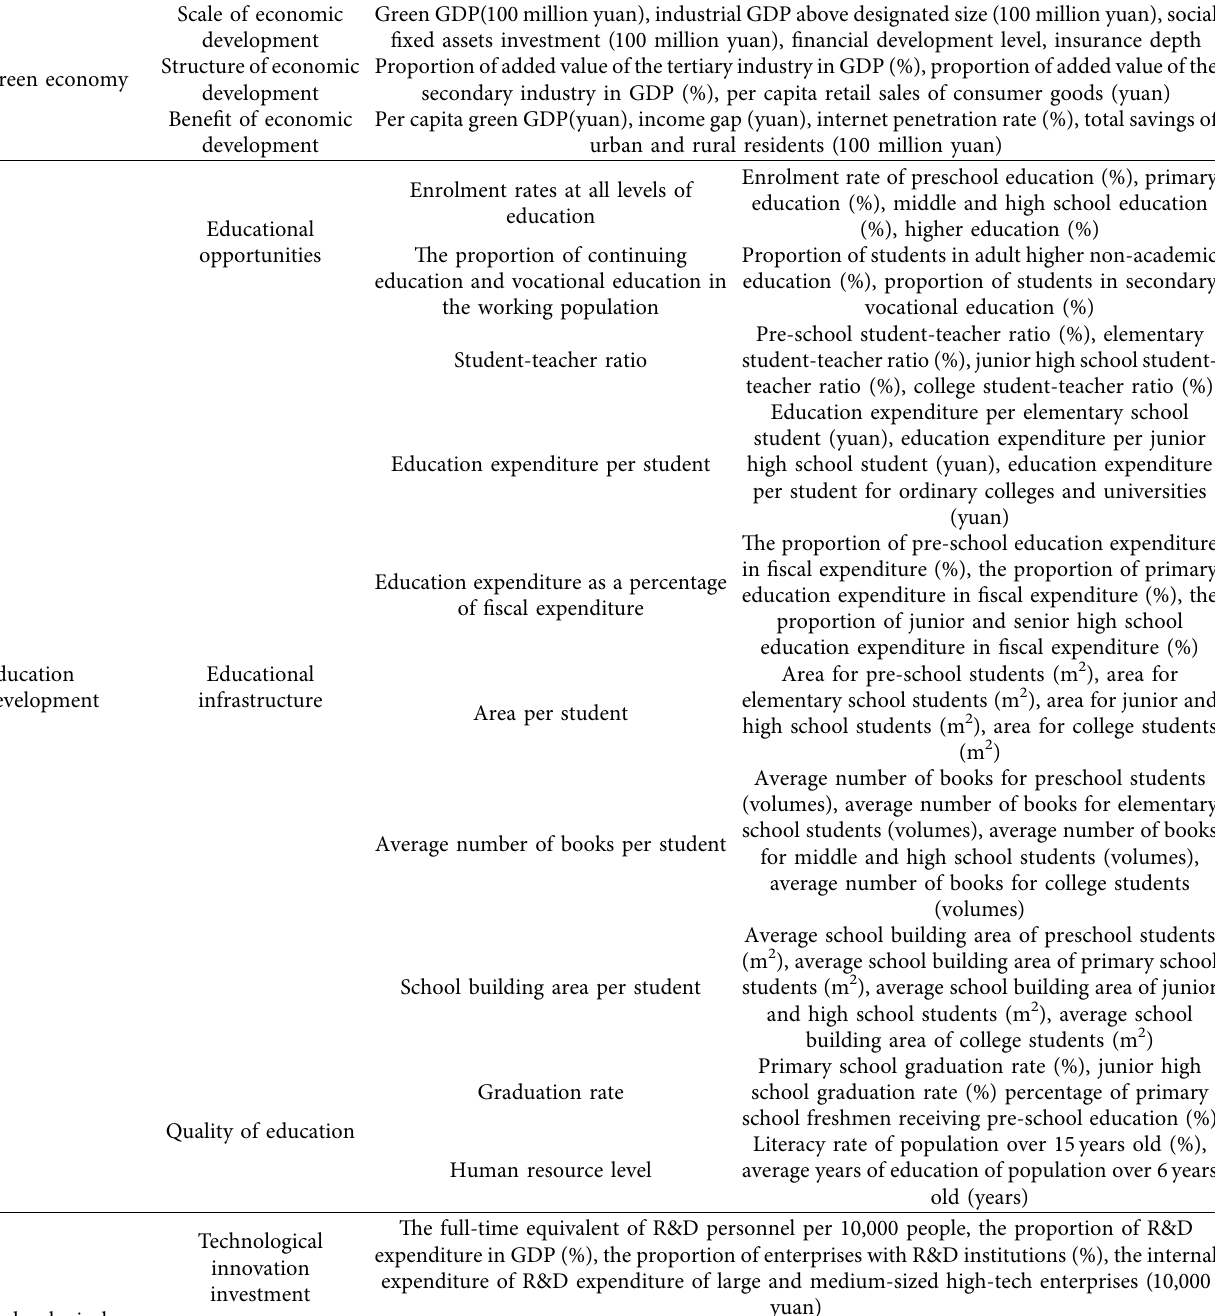
Table 2: Index system of green economy, education development, and technological innovation. Coupling